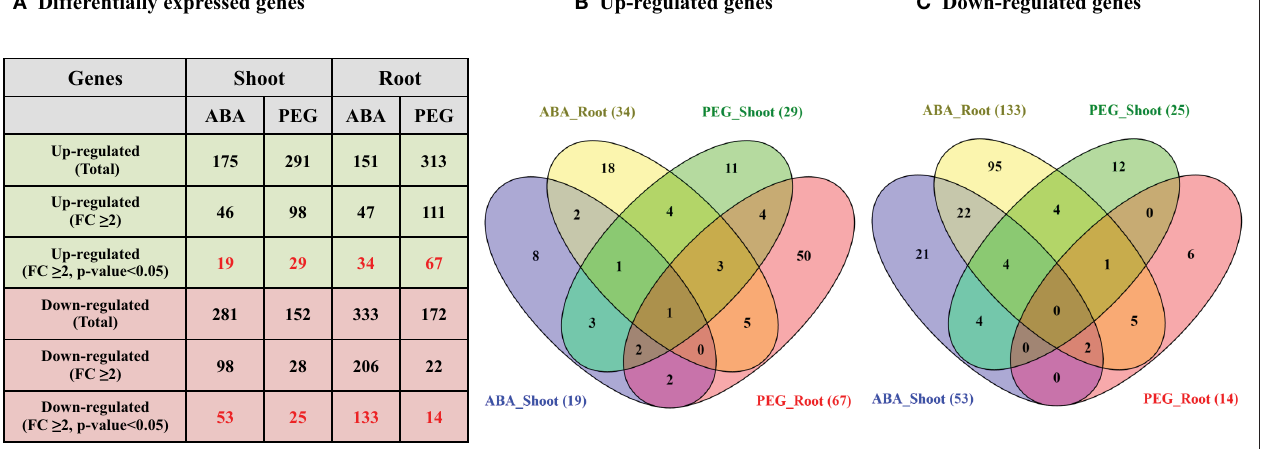
FIGURE 8 | Differential expression analysis (DEG) of sorghum cell wall related genes in ABA and PEG treated shoot and root. (A) Details of differentially expressed genes (Fold change ≥ 2.0 and p < 0.05) during stress. (B) Venn diagram representing up-regulated genes during stress. (C) Venn diagram representing down-regulated genes during